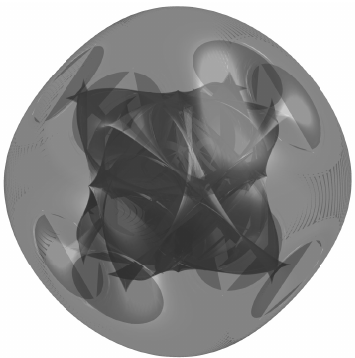
Figure 3. External and internal singular surfaces for the 4-CMG pyramid